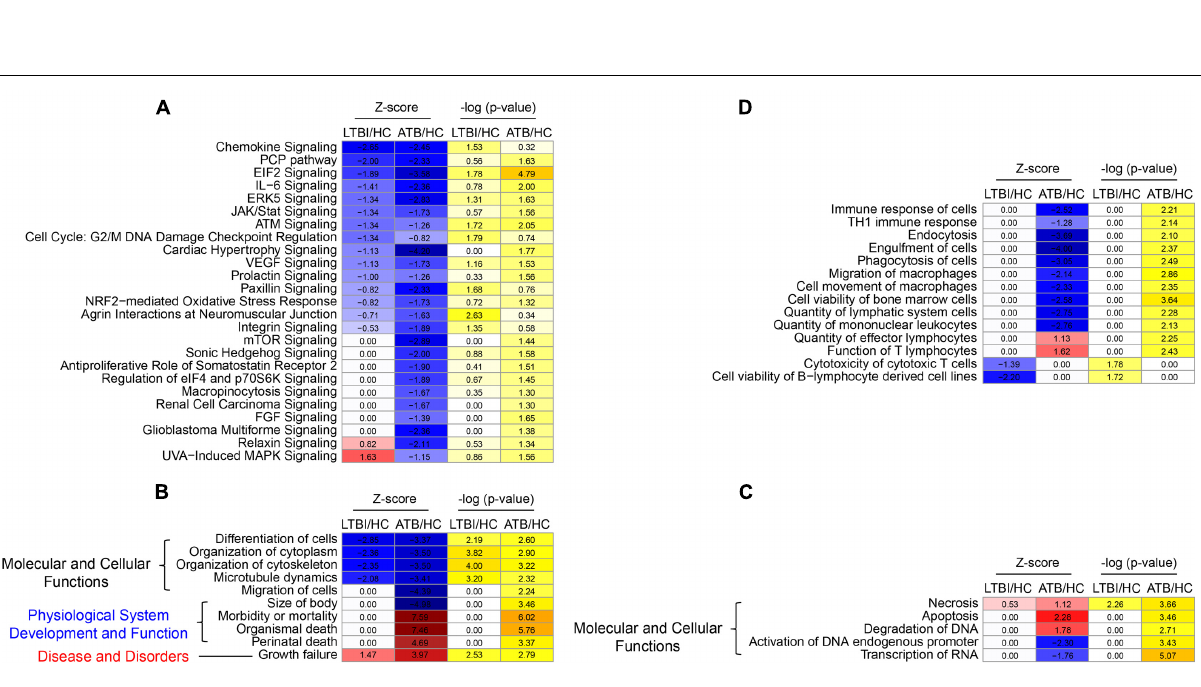
Frontiers in Microbiology |